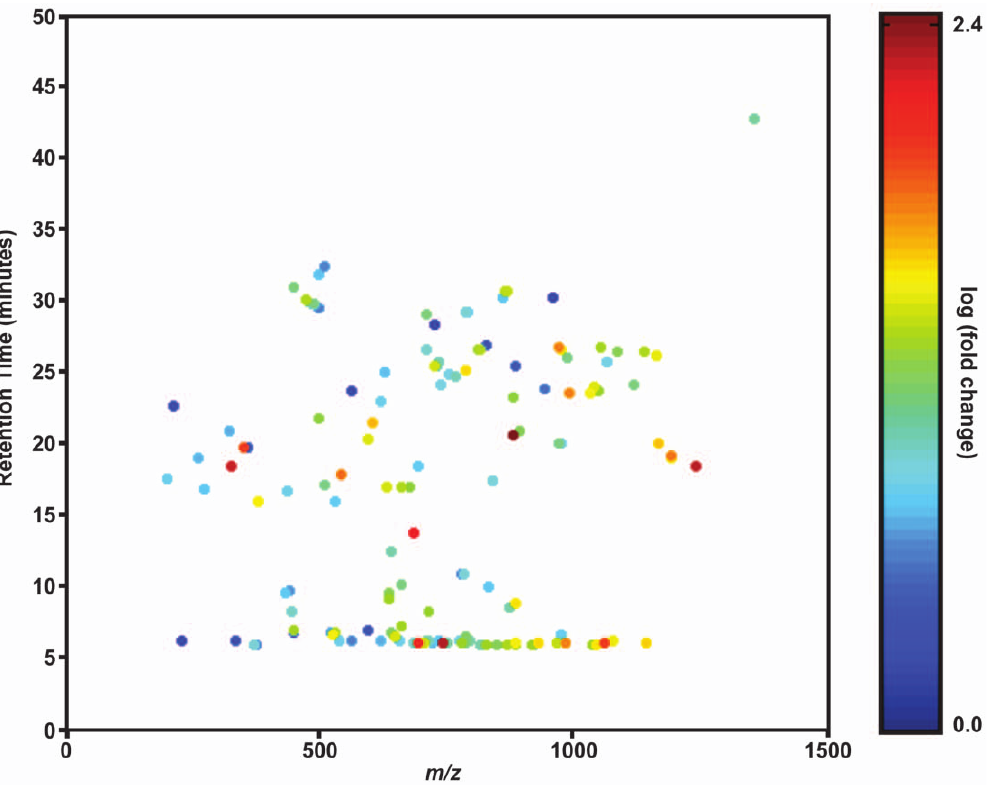
Figure 9. XCMS comparison of the lipid profiles of aposymbiotic vs. symbiotic A. pallida . Biological and technical triplicates of aposymbiotic and symbiotic anemones ( , 0.10 g each) were analyzed using negative-ion normal phase LC-MS. The spectra were aligned, normalized and compared using XCMS [27,38]. Each circle on the plot represents a lipid species as identified by m/z and retention time. The color of the circle indicates the fold change between the aposymbiotic and symbiotic data sets. The plot shows the features, after isotopes and Symbiodinium features were removed that differed between the aposymbiotic and symbiotic samples with p , 0.0001. The fold change indicates that the feature is higher in aposymbiotic anemones as compared to symbiotic anemones or vice versa. The entire data sets are available in the supporting information.